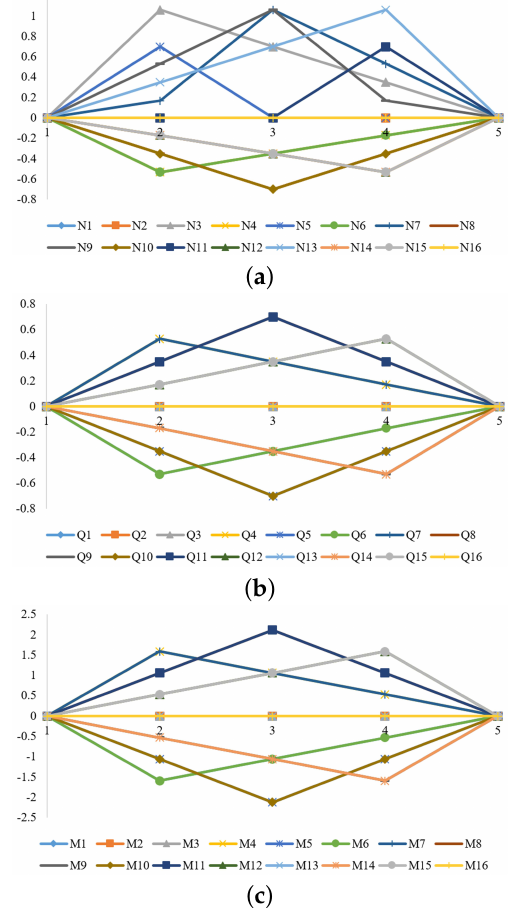
Figure 11. I.L. diagram of AFD, SFD, and BMD subject to the normal SCI structure by P = 1 loading. ( a ) I.L. of AFD N , P = 1 acting on the SCI. ( b ) I.L. of SFD Q , P = 1 acting on the SCI. ( c ) I.L. of BMD M , P = 1 acting on the